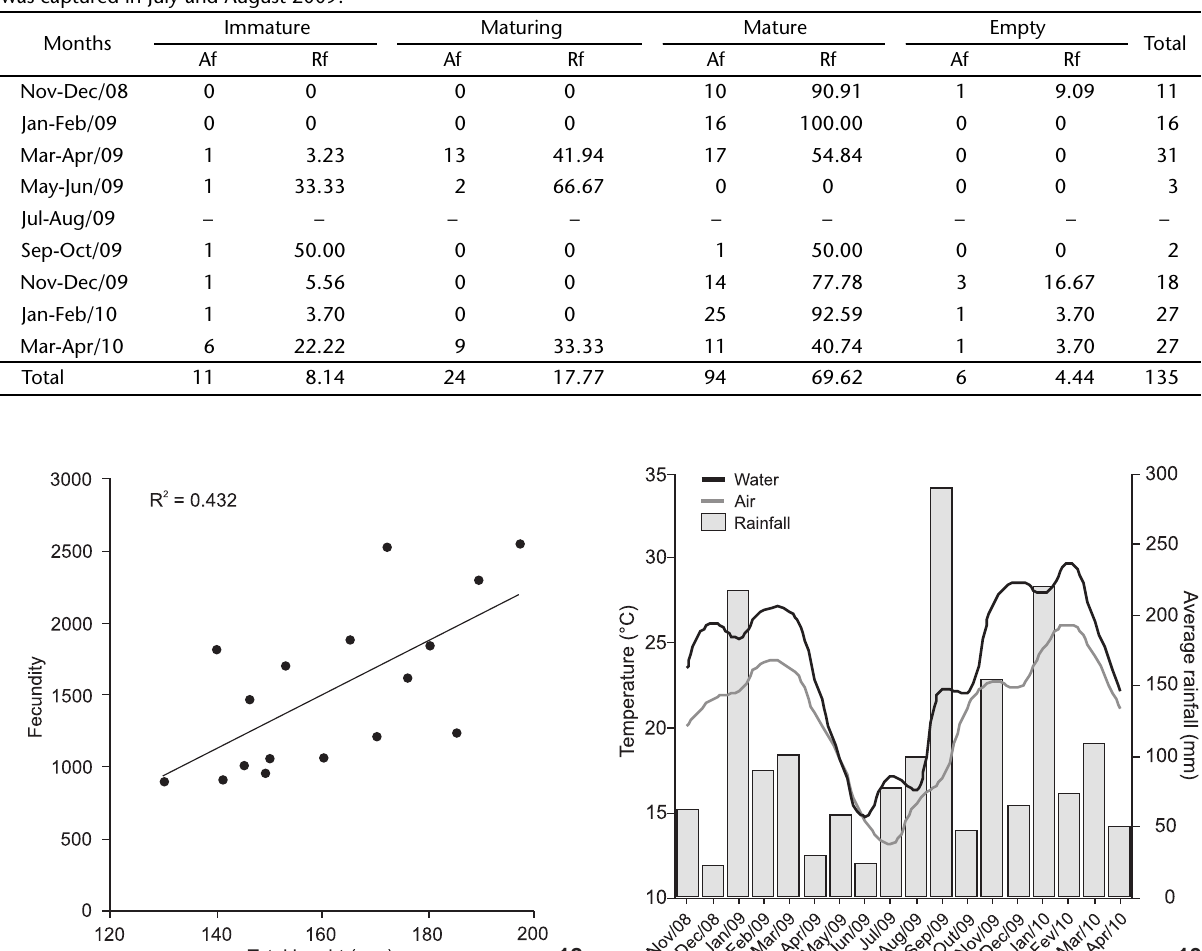
Table IV. Absolute frequency (Af) and relative frequency (Rf) for two-month periods of Trachelyopterus lucenai individuals in different maturation stages, captured in the Itapeva, Quadros and Malvas lagoons in the Tramandaí River system, Rio Grande do Sul. No individual was captured in July and August 2009.